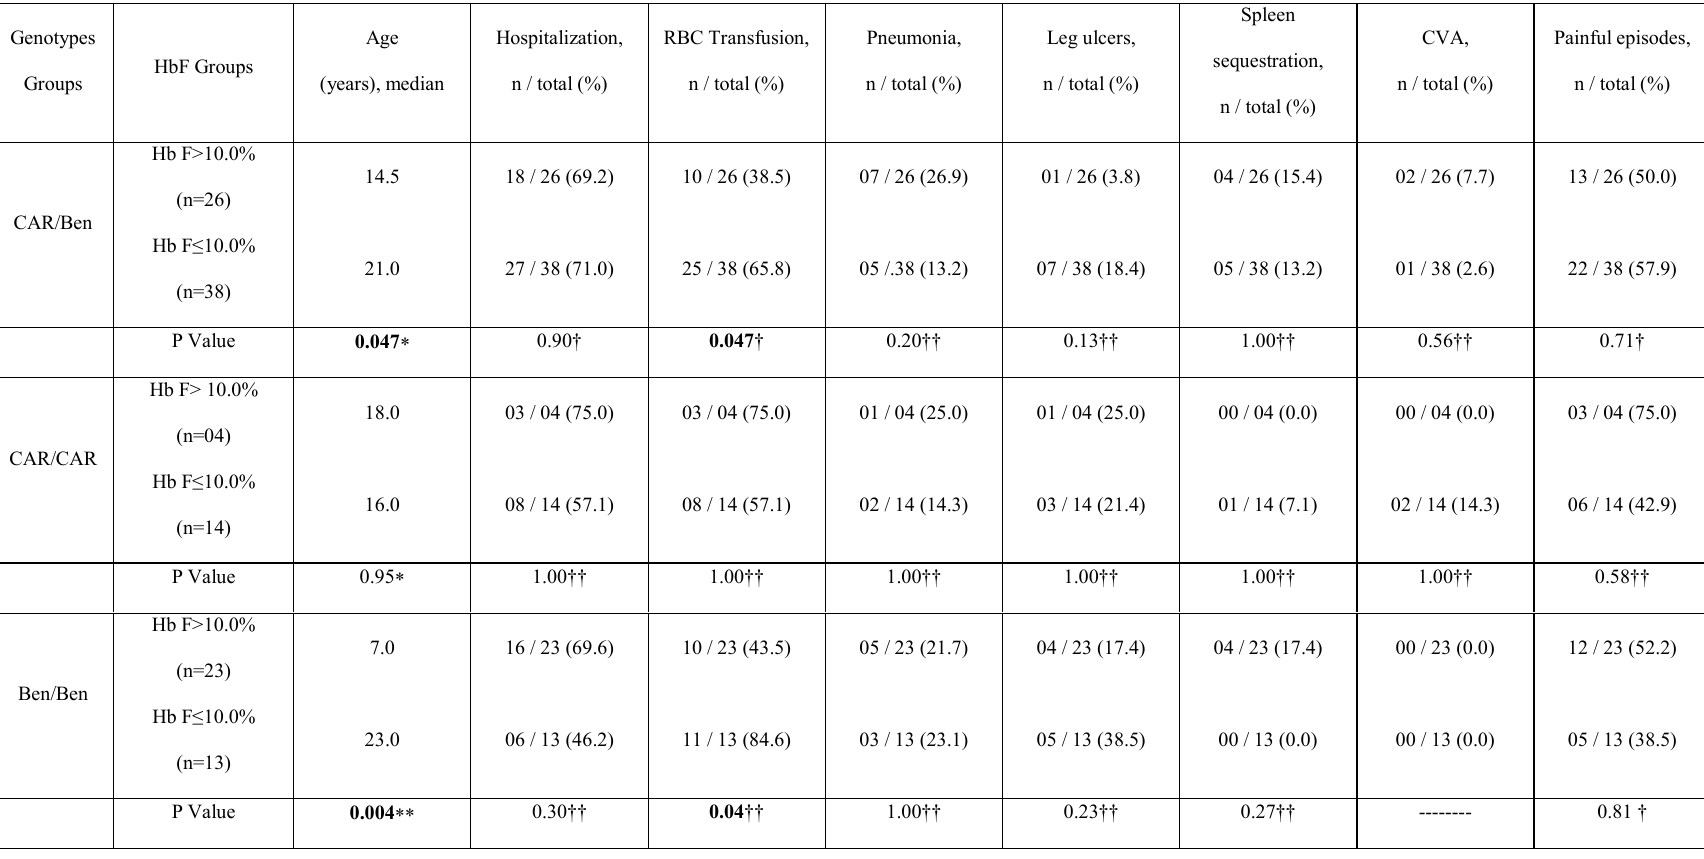
Age and phenotypic characteristics among sickle cell anemia patients from Bahia, Brazil with similar β S - globin gene haplotypes and different HbF levels. Significant results of statistical tests (at the 5% level) are shown in bold face